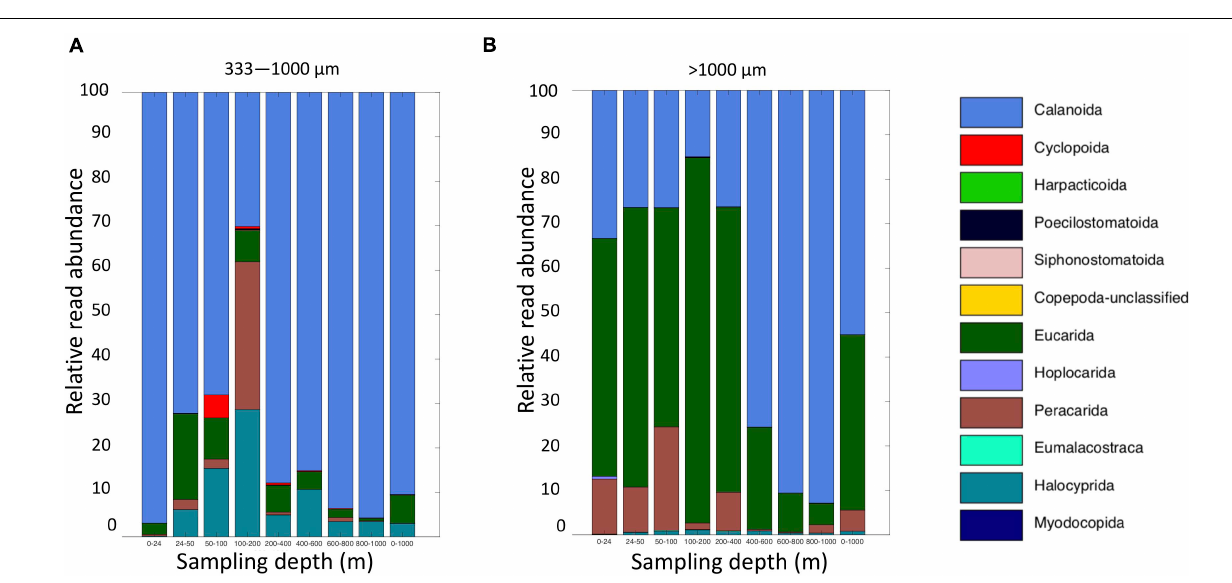
FIGURE 10 | Relative read abundances of classifications of Level 6 taxa identified as crustaceans (Copepoda, Eumalacostraca, Myodocopa, Thecostraca) (A) MOCNESS small size fraction and (B) MOCNESS large size